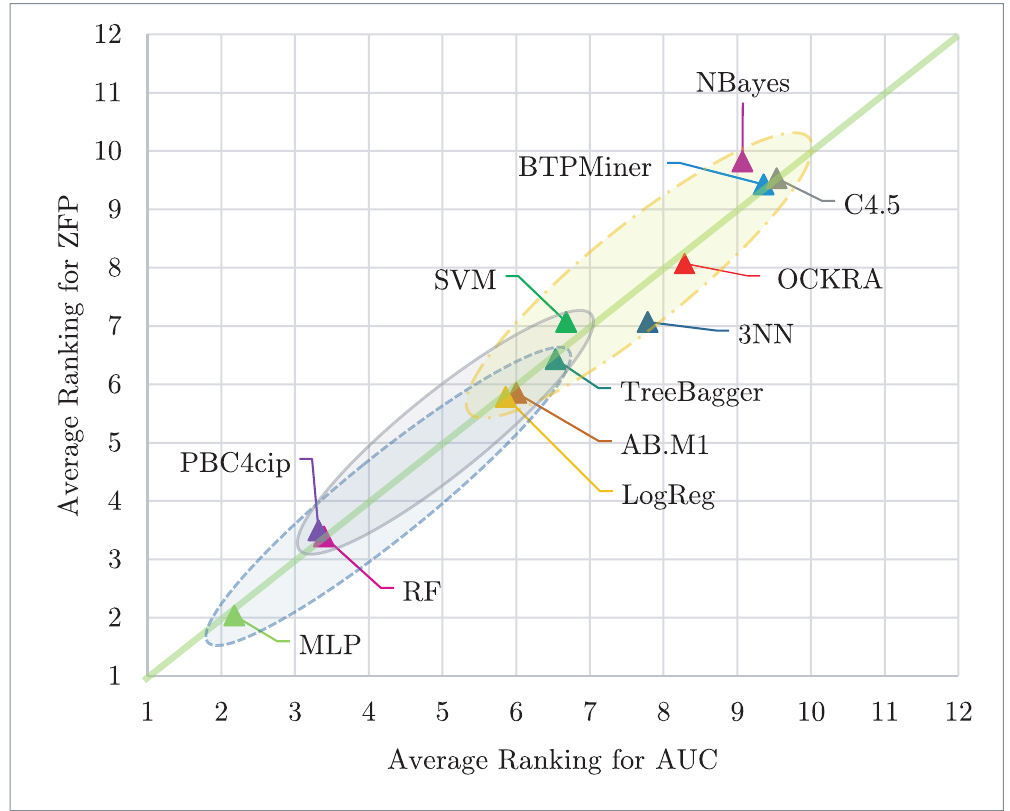
Figure 6. Average ranking for the tested classifiers, according to AUC vs ZFP. Those results closest to the origin (1,1) are the best considering both performance metrics; in addition, those enclosed in an ellipse have no statistical differences among them regarding both evaluated